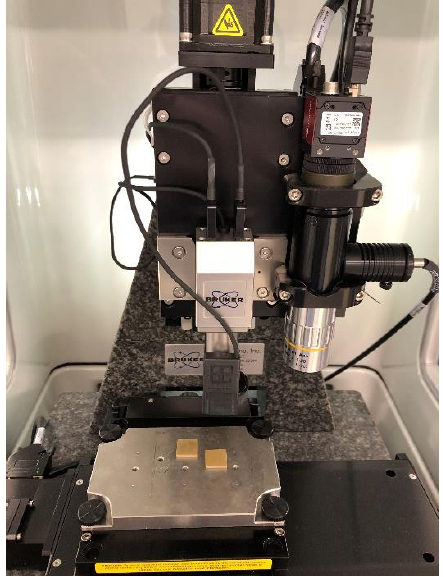
Figure 7. Measuring the hardness and modulus of elasticity of samples using a micro-indenter device.